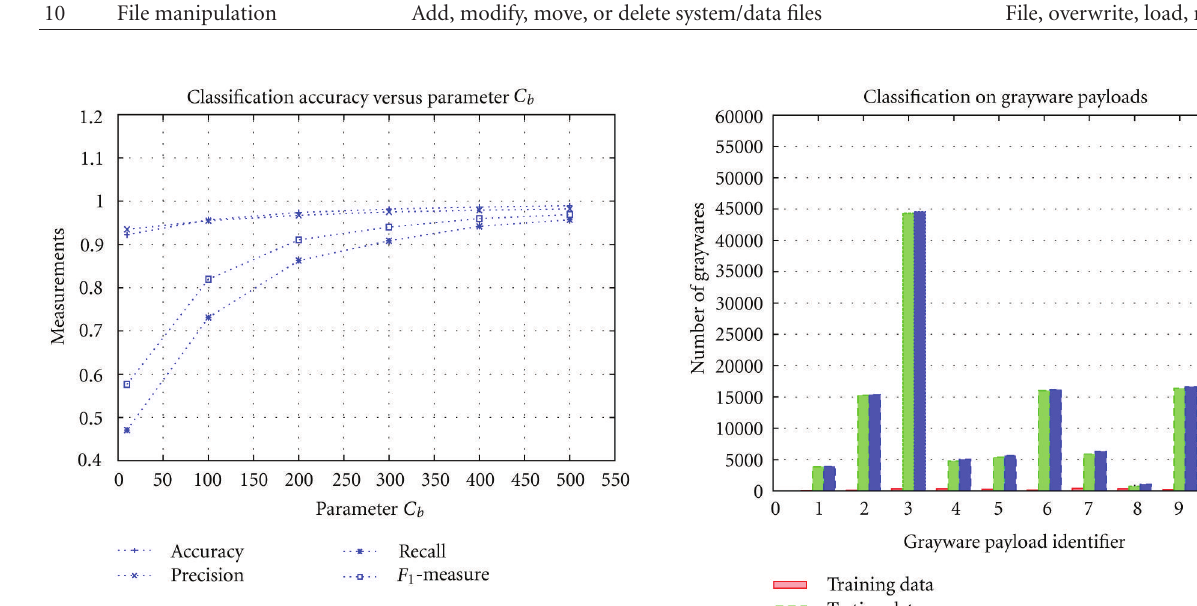
Figure 15: Relation between parameter C b and accuracy on Carried Payload.